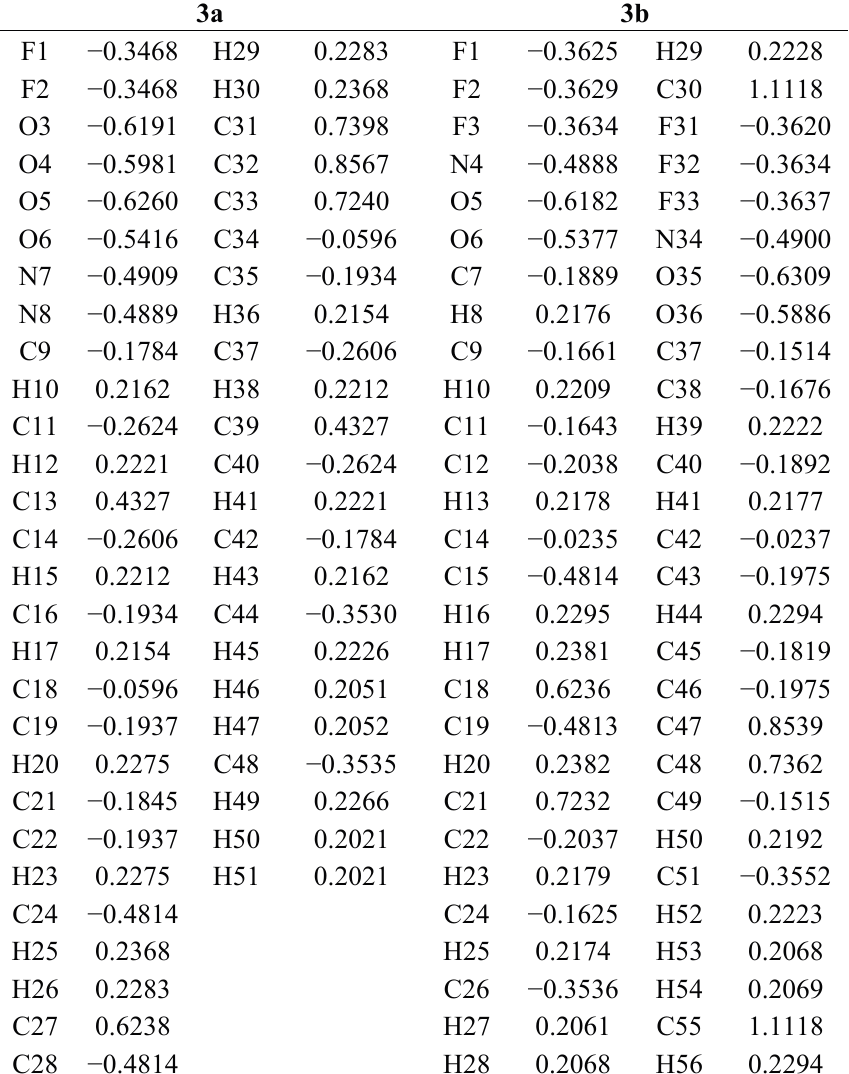
Table 3. The natural atomic charges calculated at the B3LYP/6-311G (d,p)